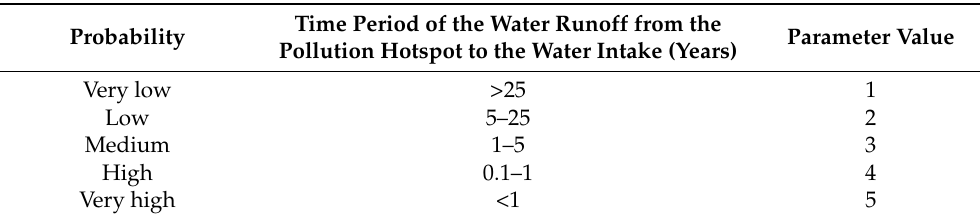
Table 3. The categorization of the parameter of vulnerability to emergency (V) (own study based on [49], modified by